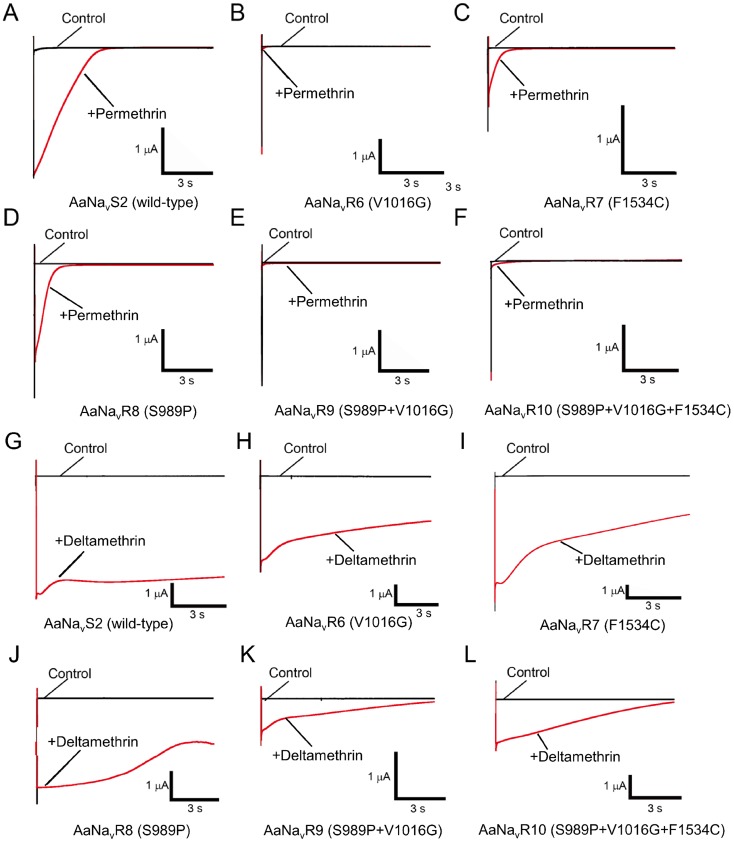
Pyrethroid-induced tail currents from oocytes injected with various types of Vssc.(A, G) AaNavS2 (wild-type); (B, H) AaNavR6 (V1016G); (C, I) AaNavR7 (F1534C); (D, J), AaNavR8 (S989P); (E, K), AaNavR9 (S989P+V1016G); (F, L) AaNavR10 (S989P+V1016G+F1534C) in the absence (control) or presence of 100 nM permethrin (A–F) or 100 nM deltamethrin (G–L).